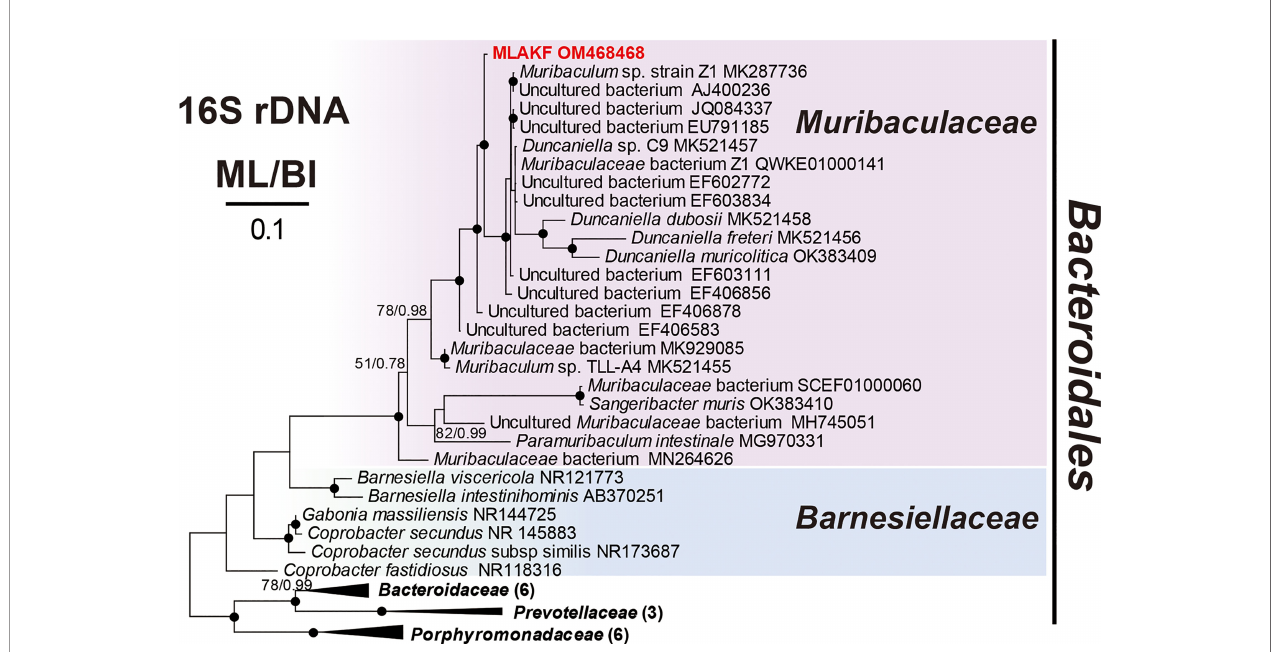
FIGURE 6 | Maximum likelihood (ML) tree based on the 16S rRNA genes showing the positions of MLAKF (in red) with a GTR + I + Г model. The numbers on the nodes represent the bootstrap values of the ML and the posterior probability of the Bayesian inference (BI). The black dot on the node represents the bootstrap value > 95%. Genbank accession numbers are given following the species names. All branches are drawn to